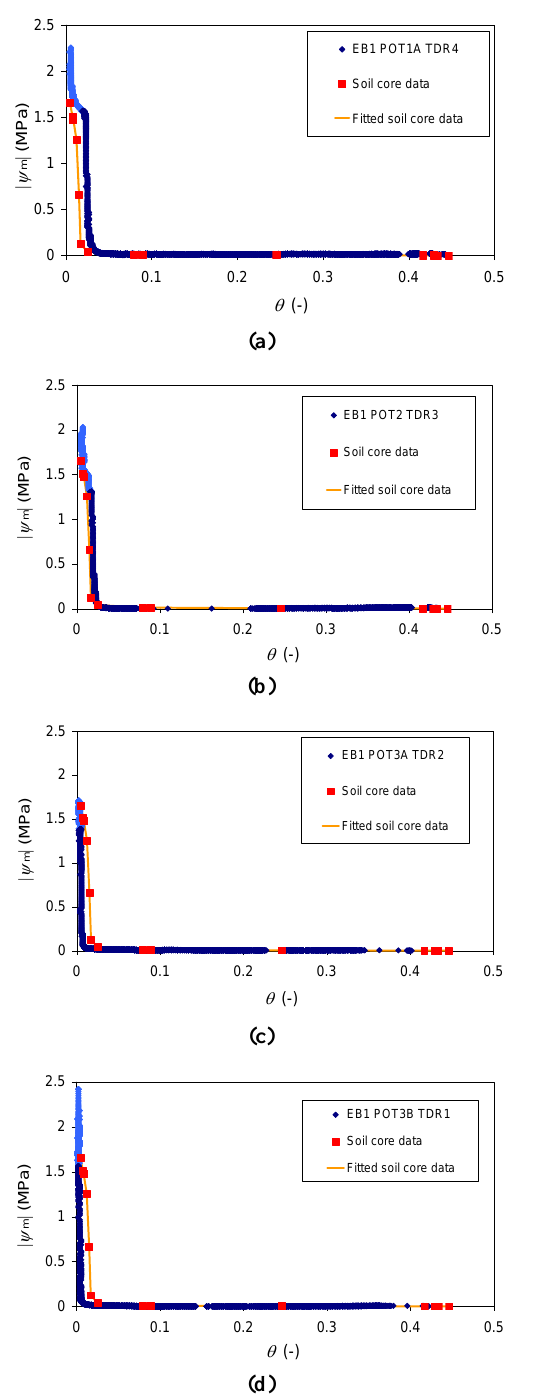
Fig. 8. Moisture retention curves of EB1 for the paired polymer ten- siometers (POTs) and time domain reflectometers (TDR) together with gravimetric data from soil cores, and fitted retention curve. The minus sign of the matric pressure values ( ψ m (MPa)) has been omitted.